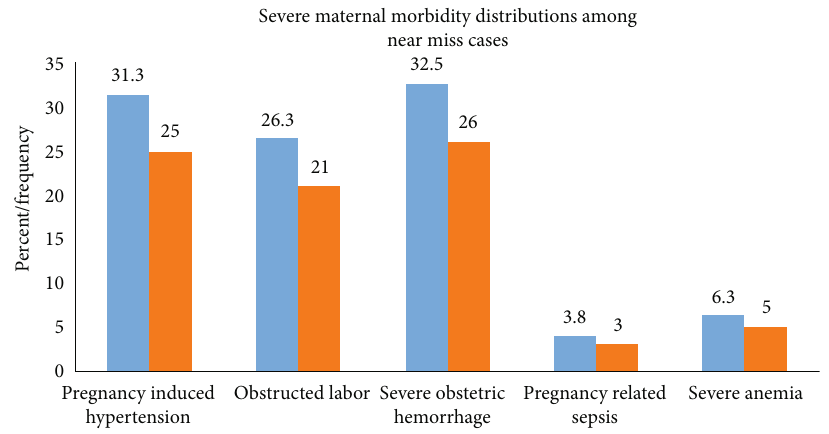
Figure 1: Maternal morbidity among near-miss cases admitted in Western Arsi zone public hospitals, Ethiopia,